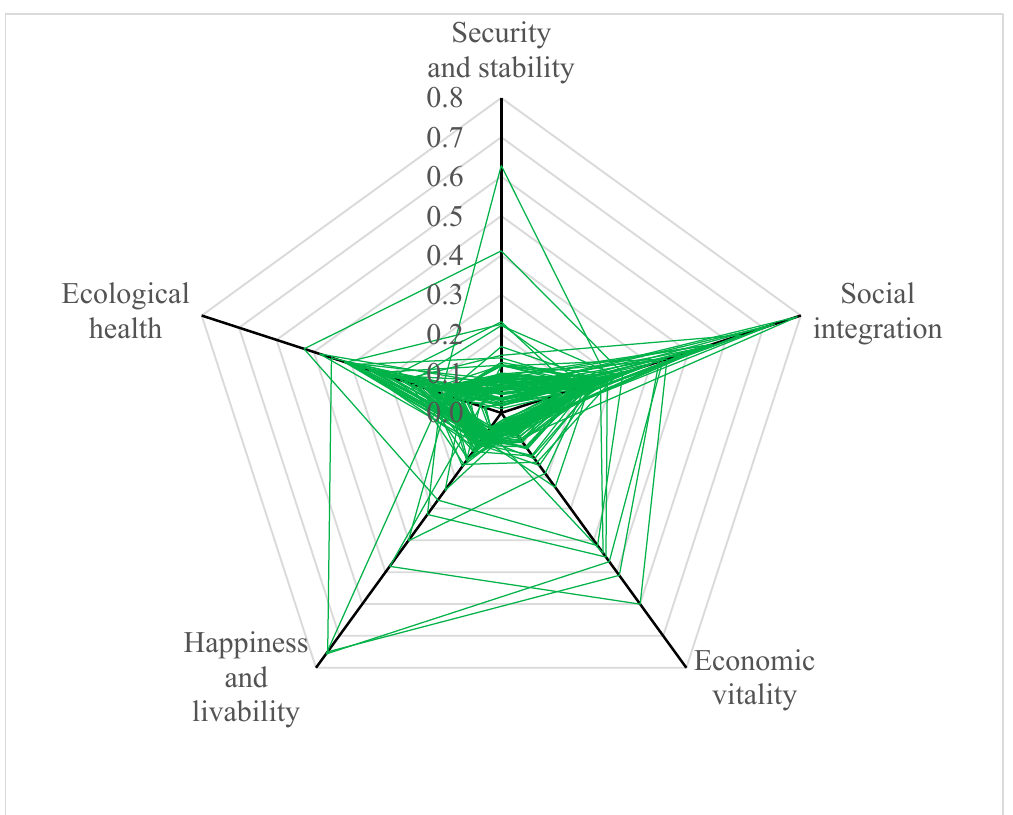
Figure 5. Radar chart of urbanization sustainability by dimension.